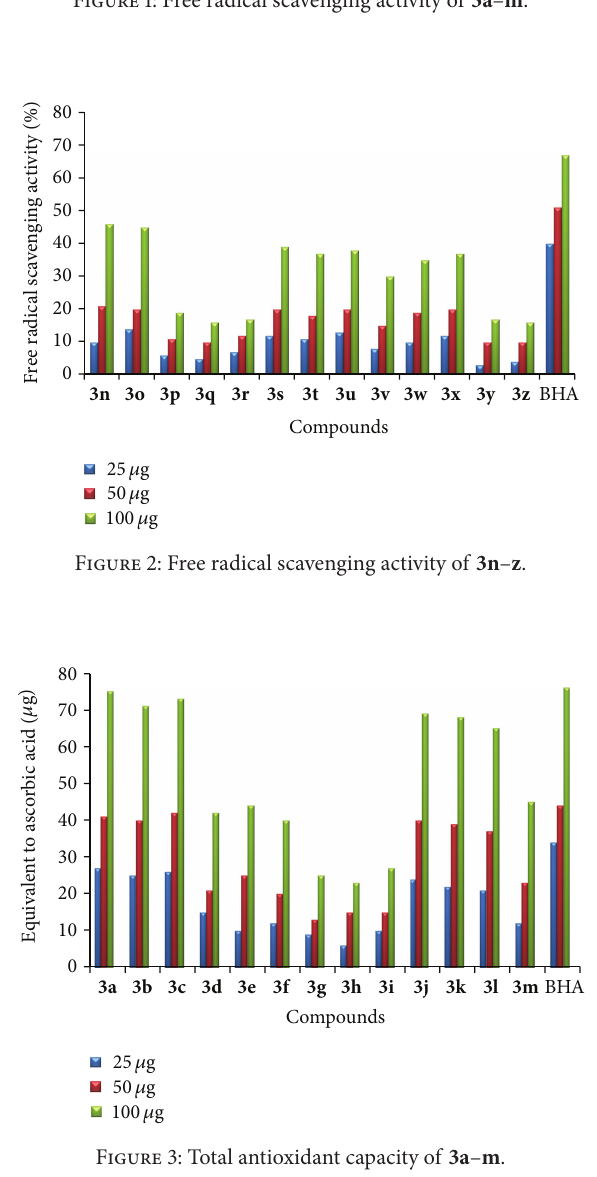
Figure 1: Free radical scavenging activity of 3a – m .